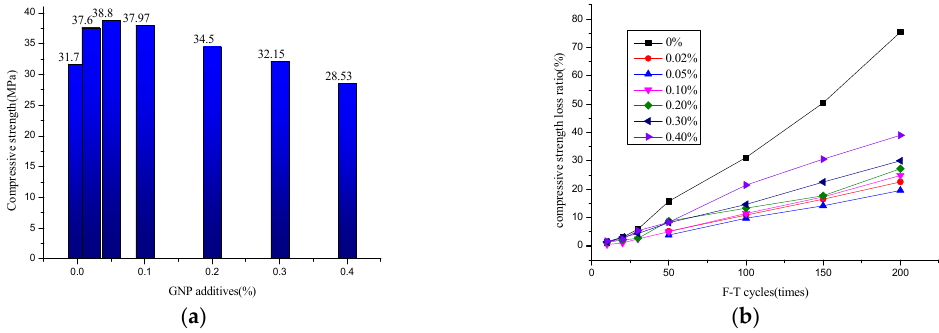
Figure 7. ( a ). Twenty-eight-day compressive strength of different GNP additives. ( b ) D f versus F-T actions. The compressive strength of concrete with different GNP additives.